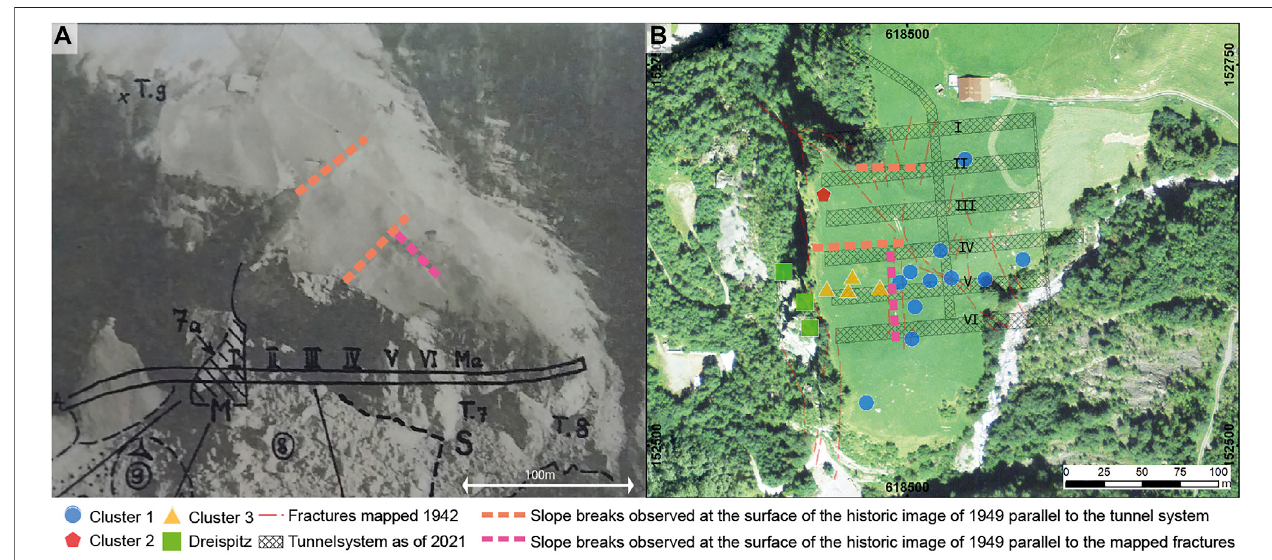
FIGURE 10 | Surface morphology directly after the detonations in 1947; (A) Morphologic surface expressions due to displacements within the tunnel system caused by the detonations, seen on an aerial image of the Flue taken in 1948 and (from Beck, 1948, Tafel IV); (B) Supposed fractures mapped in (A) projected on the latest aerial image of the area with the location and numbering (I – VI) of the tunnel system 100 m of elevation